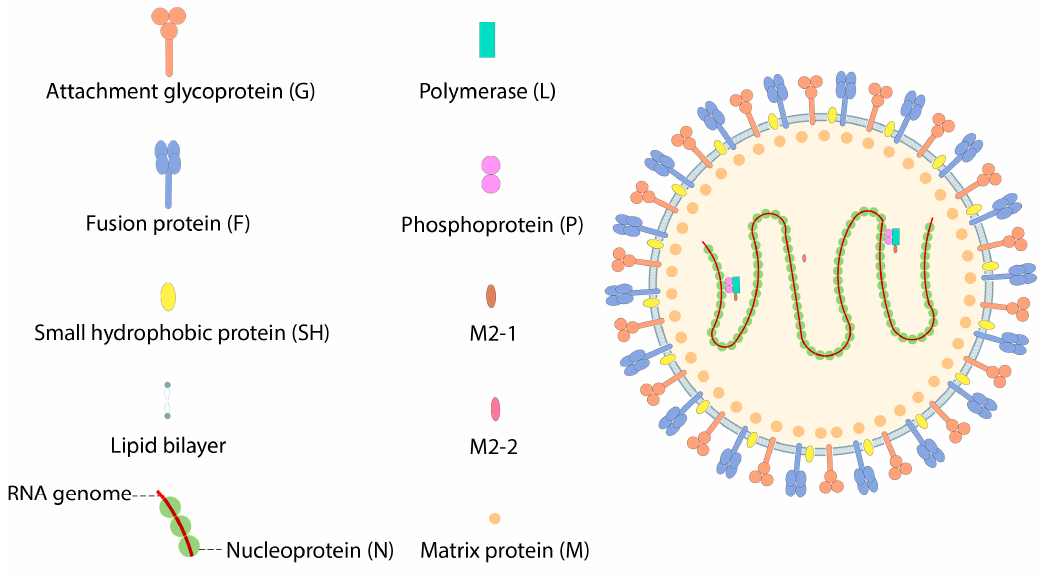
Figure 10. Structure of Respiratory Syncytial virus.